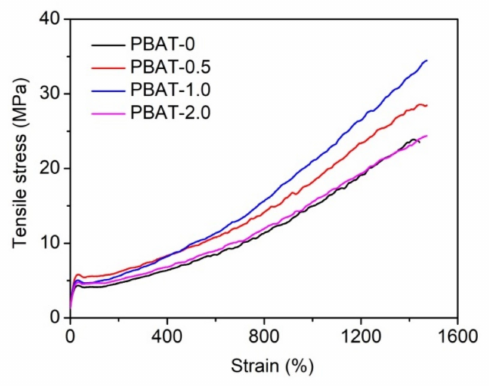
Figure 4. Tensile stress versus strain of PBAT/Ti 3 C 2 T X nanocomposite casting films.